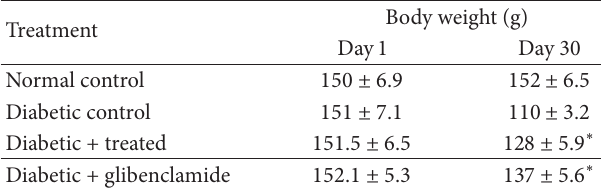
Table 2: Effect of Triticum aestivum on body weight in strepto- zotocin-induced diabetic